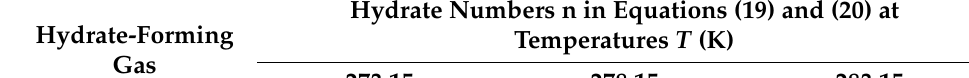
Table 1. Hydrate numbers n for some gases at T > 273 K on three-phase gas–water–hydrate equilib- rium line.